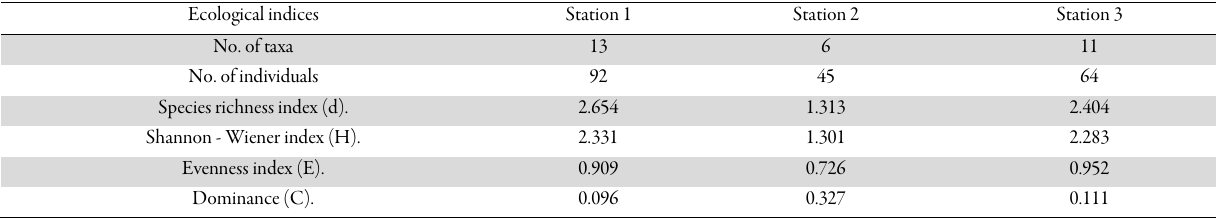
Table 4. Diversity, richness, evenness and dominance indices of macroinvertebrates at the study stations of River Idemili Ecological indices